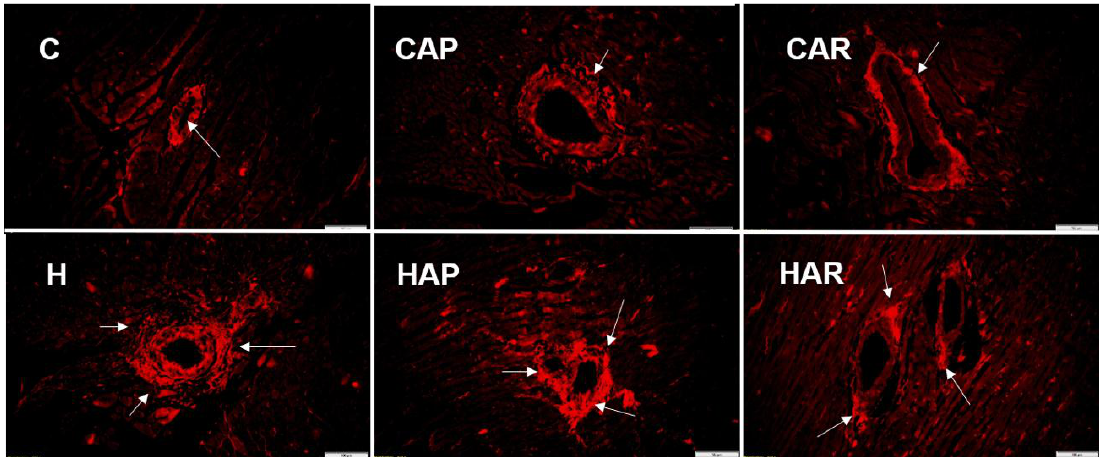
Figure 4. Picrosirius red staining of left ventricular perivascular collagen deposition (magnification ×20; scale bar = 100µm) showing fibrosis (indicated by arrows) in rats fed corn starch diet (C), corn starch diet + achacha pulp (CAP), corn starch diet + achacha rind (CAR), high-carbohydrate, high-fat diet (H), high-carbohydrate, high-fat diet + achacha pulp (HAP), and high-carbohydrate, high-fat diet + achacha rind (HAR).